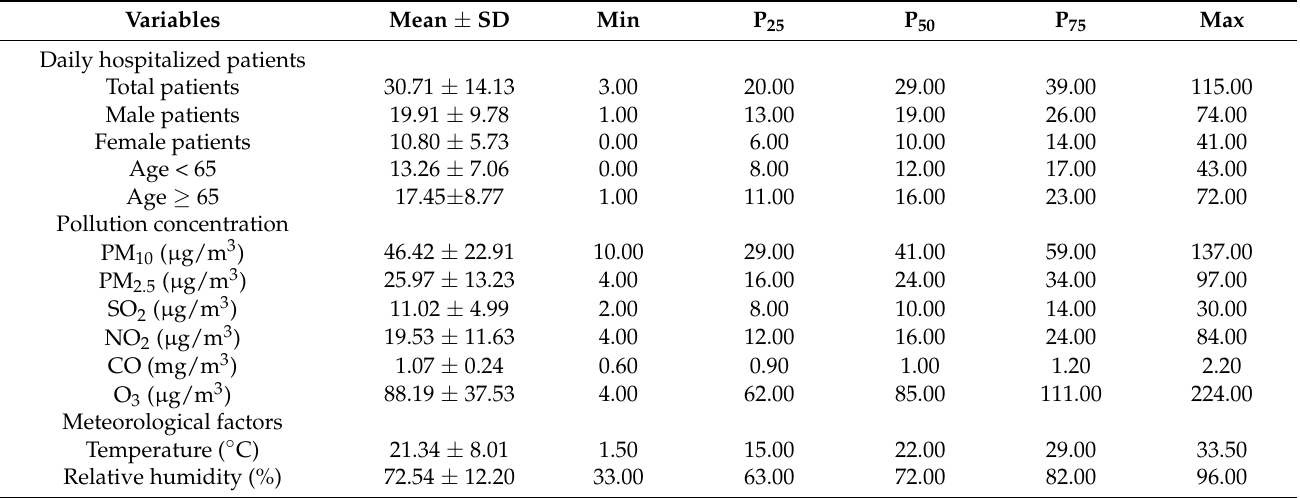
Table 1. Summary statistics of daily hospitalized patients for CHD, air pollution concentrations and weather conditions in Ganzhou